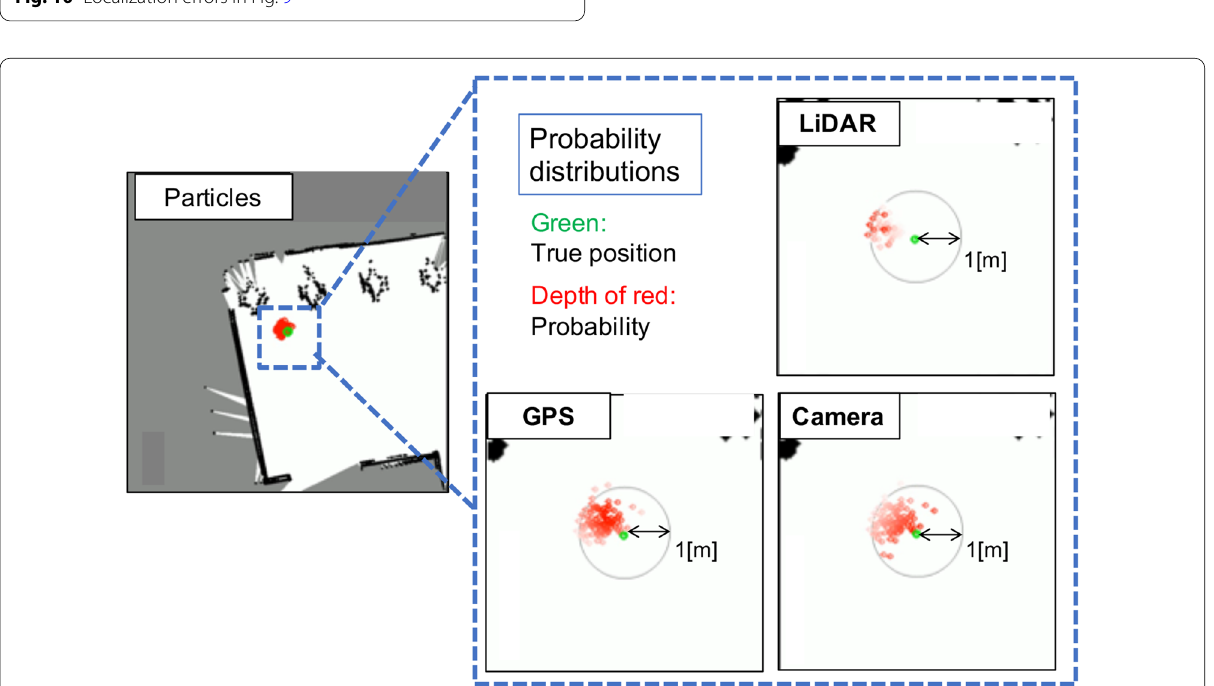
Fig. 11 Probability distributions at 152 s in Fig. 9